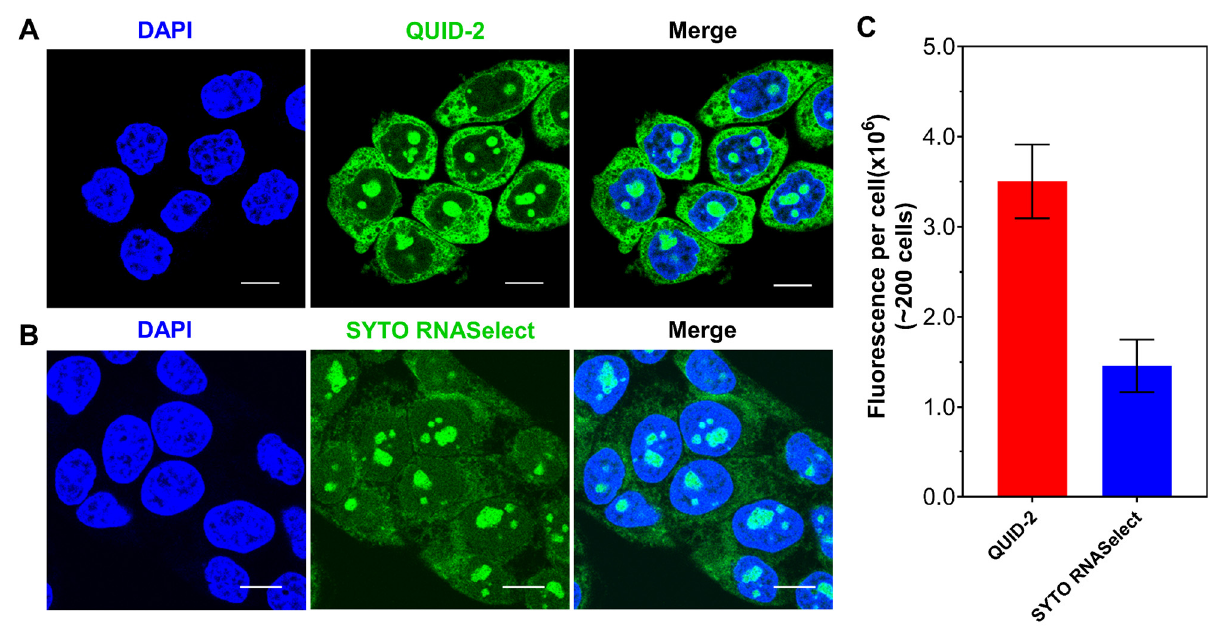
Figure 3. ( A ) Imaging of fixed HeLa cells stained with QUID − 2 (0.5 μ M, λ ex = 488 nm, λ em = 500–600 nm, green). ( B ) Imaging of fixed HeLa cells stained with SYTO RNASelect (0.5 μ M, λ ex = 488 nm, λ em = 500–600 nm, green). The nucleus was visualized by DAPI ( λ ex = 405 nm, λ em = 430–490 nm, blue). ( C ) Quantification of the QUID − 2 and SYTO RNASelect fluorescence intensity for ( A , B ). For each sample, approximately 200 cells were measured, and the standard error was calculated from a set of three replicate experiments. Scale bars for cell image: 10 μ